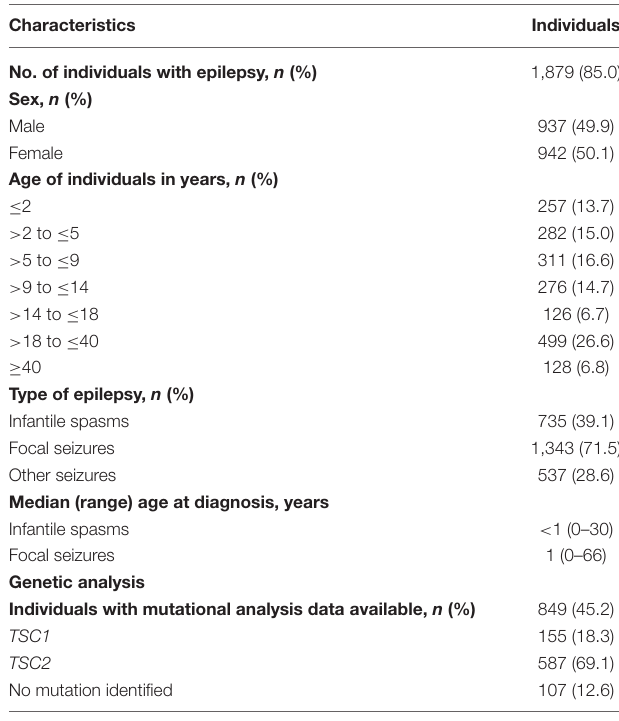
TABLE 1 | Demographics and characteristics of individuals with TSC and